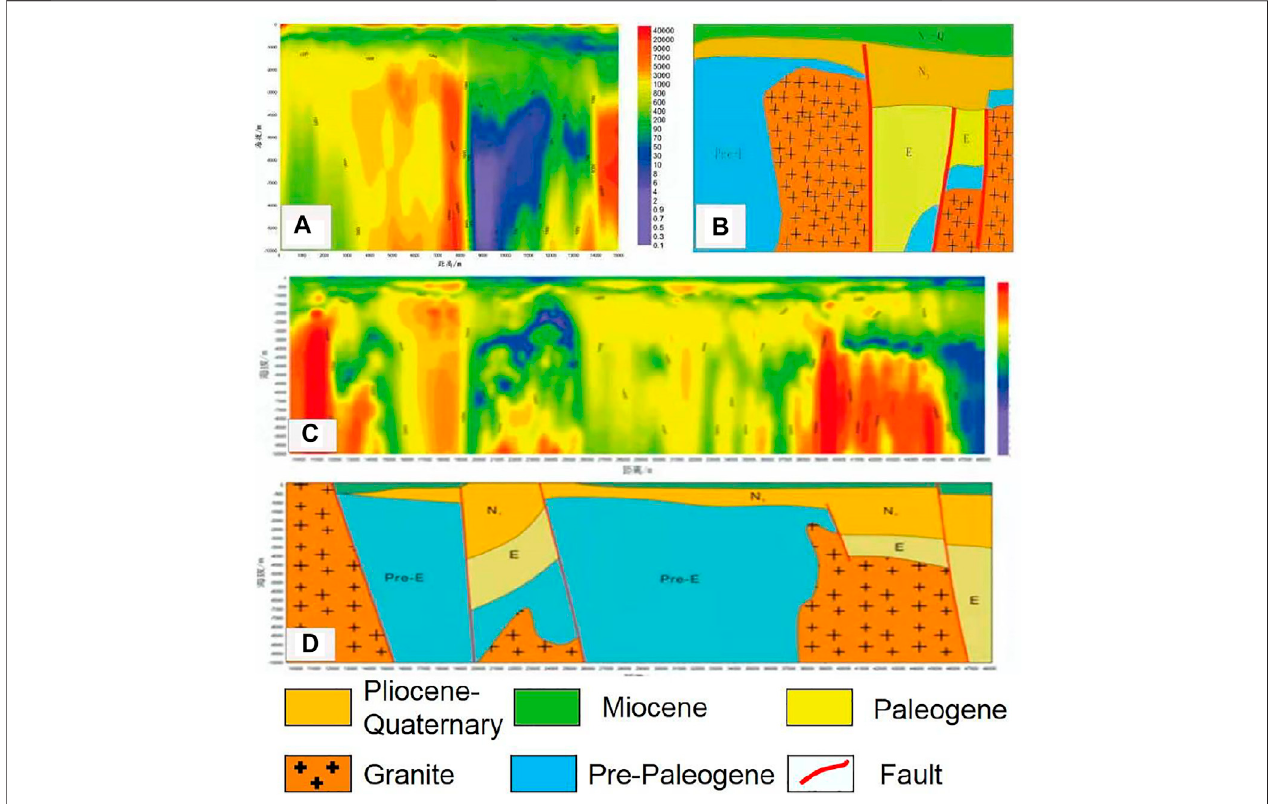
FIGURE 11 | Pro fi les of apparent resistivity inversion based on wide fi eld electromagnetic method and corresponding geological interpretation in North Hainan Province (Tan et al., 2020).